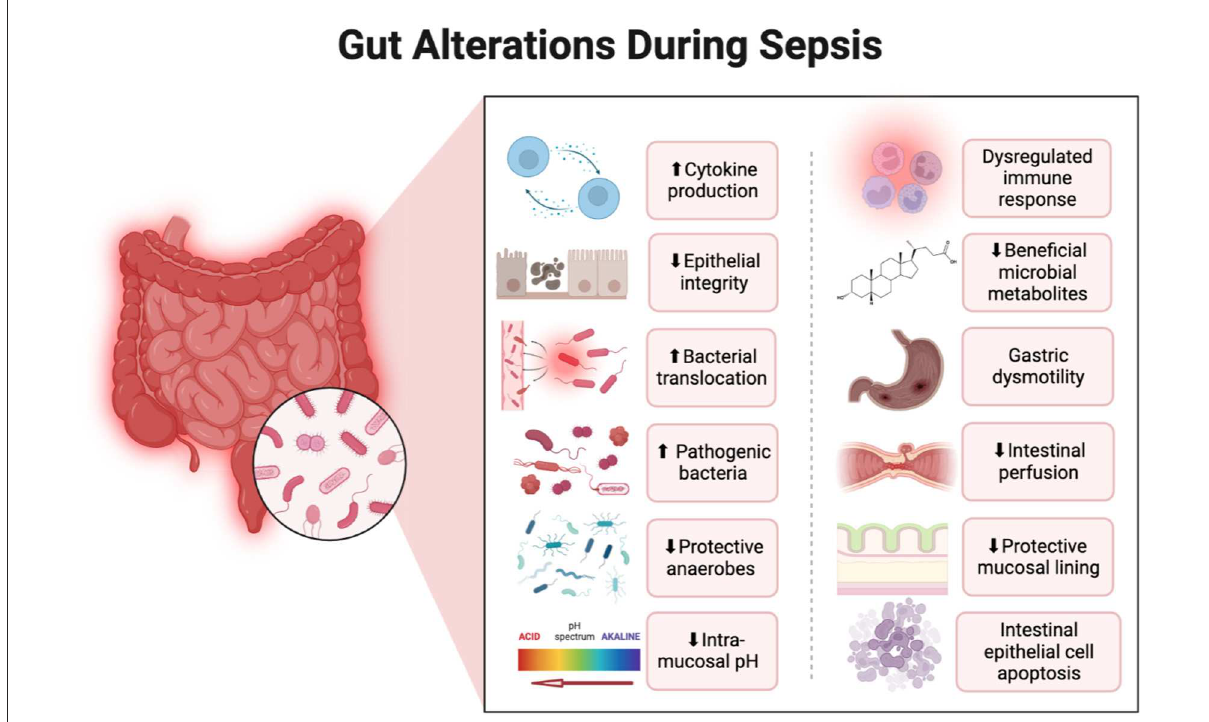
FIGURE1 Alterations in the gastrointestinal system that occur during sepsis with a focus on changes to the gut microbiome. Created with Biorender.